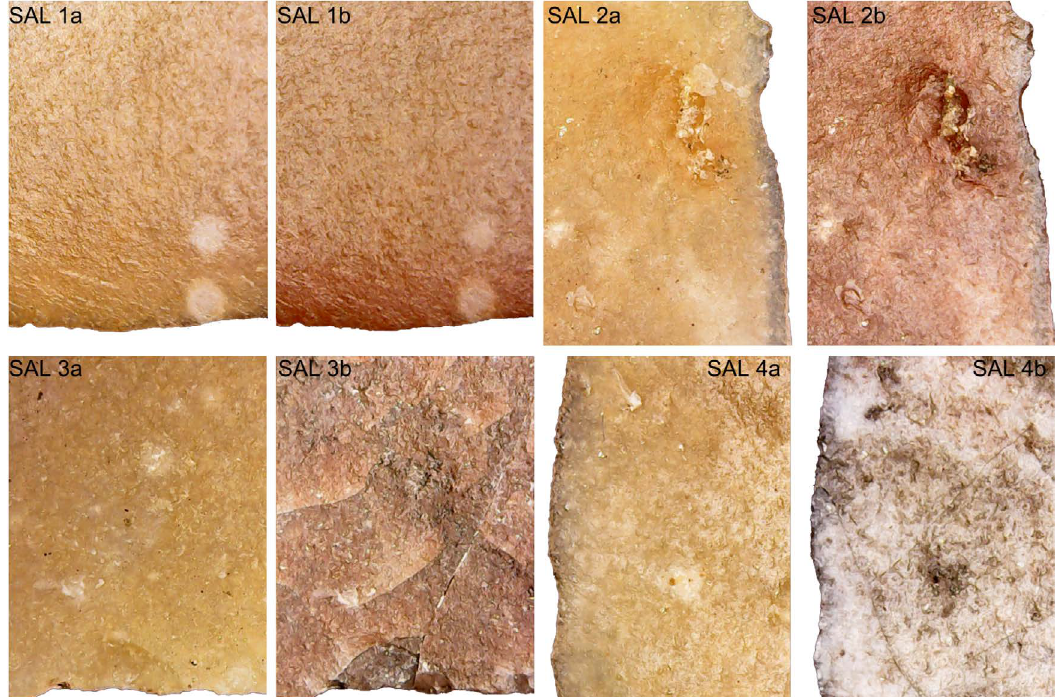
Figure 5. Described Surface Alteration Levels (SAL) for samples of Bergerac flint. SAL 1a and 1b where dehydration is almost absent and the developed color is associated with the original; SAL 2a and 2b with a higher development of dehydration, higher topographic visibility, and development of the characteristic waxy luster; SAL 3a and 3b where surface has been blackened because of carbonization; SAL 4a and 4b where surface presents extreme dehydration associated with color white of incineration.